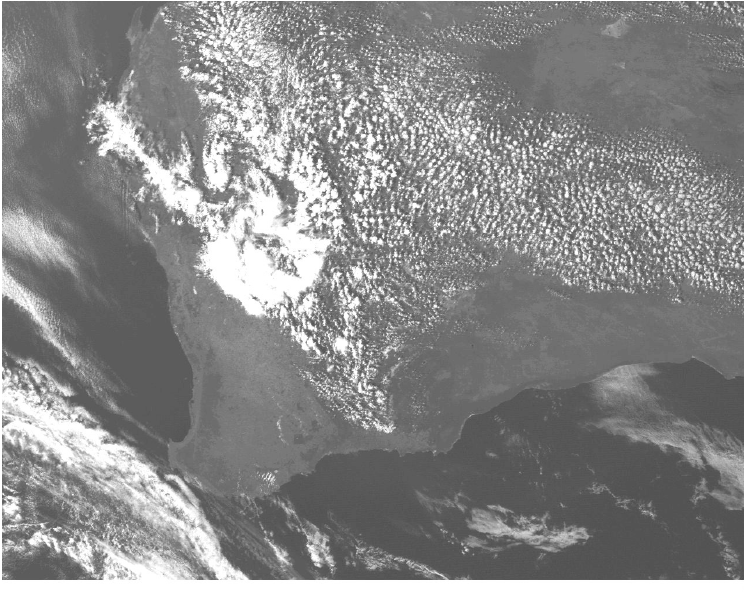
Figure 2. Cloud formation over Western Australia-Satellite image originally processed by the Bureau of Meteorology from the geostationary meteorological satellite MTSAT-1R operated by the Japan Meteorological